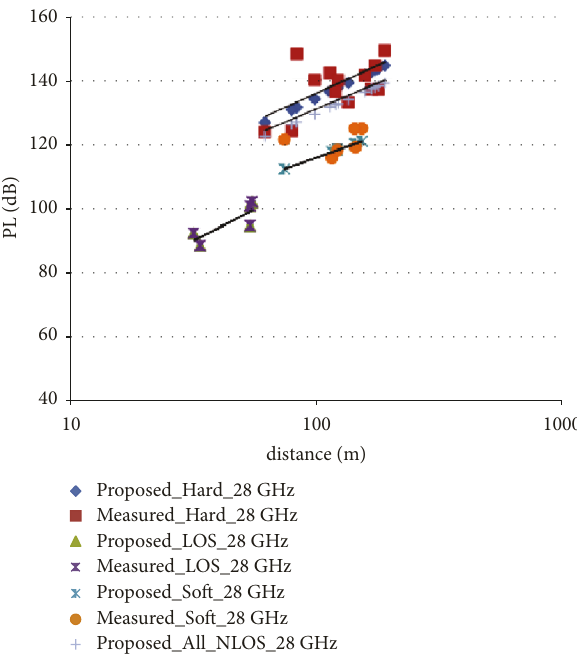
Figure 5: Proposed Model at frequency of 28 GHz.